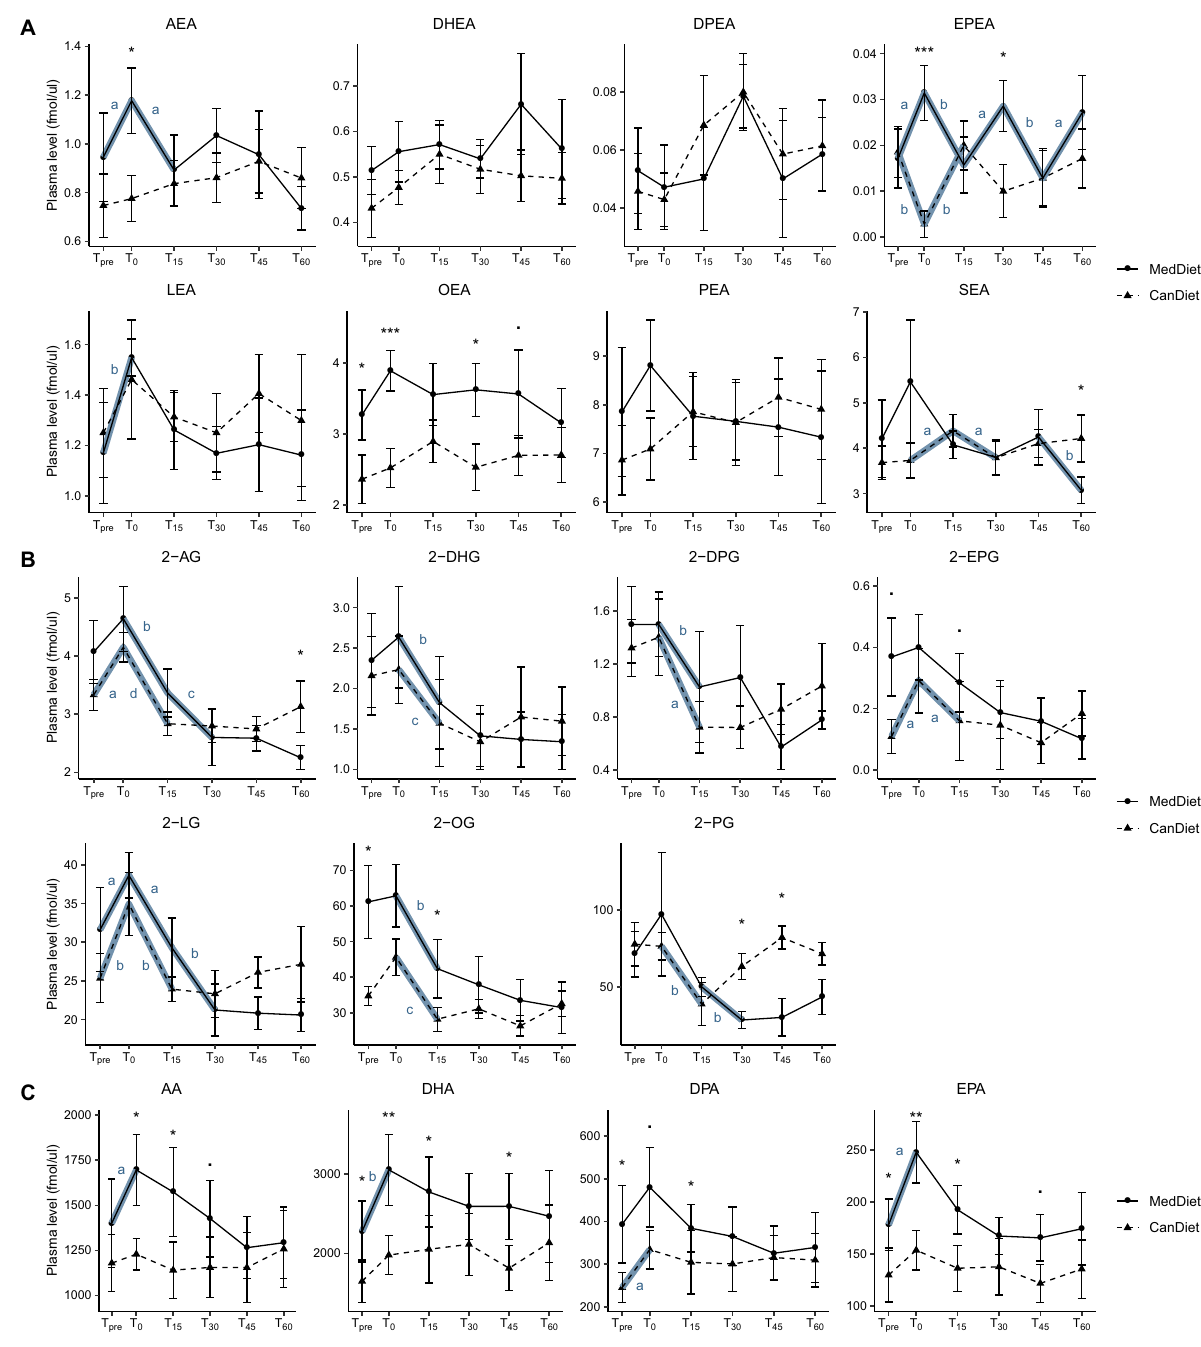
Figure 2. Response curves of eCBome mediators and precursors (fmol/μl) to maximal aerobic test according to the diet. Panels show results for ( A ) N -acylethanolamines, ( B ) monoacylglycerols and ( C ) polyunsaturated fatty acids. The graph represents the mean with the standard error of the plasmatic concentrations of these lipids at each time point for the two diets. T pre corresponds to the initial concentration before the aerobic test, T 0 corresponds to the immediate end of the aerobic test and T 15 , T 30 , T 45 and T 60 correspond to the recovery phase. Lipid concentrations have been normalized using ranked values fitted into mixed linear-effect models (LME) and differences between diets and times have been tested by analysis of variance (ANOVA). For difference between diets, significance was set at p < 0.1 (.), p < 0.05 (*), p < 0.01 (**) and p < 0.001 (***). For difference between times, indicated by bold blue line, significance was set at p < 0.1 (a), p < 0.05 (b), p < 0.01 (c), p < 0.001 (d). N = 7 per diet. Names of the molecules are anandamide (AEA), N -palmitoylethanolamine (PEA), N -oleoylethanolamine (OEA), N linoleoylethanolamine